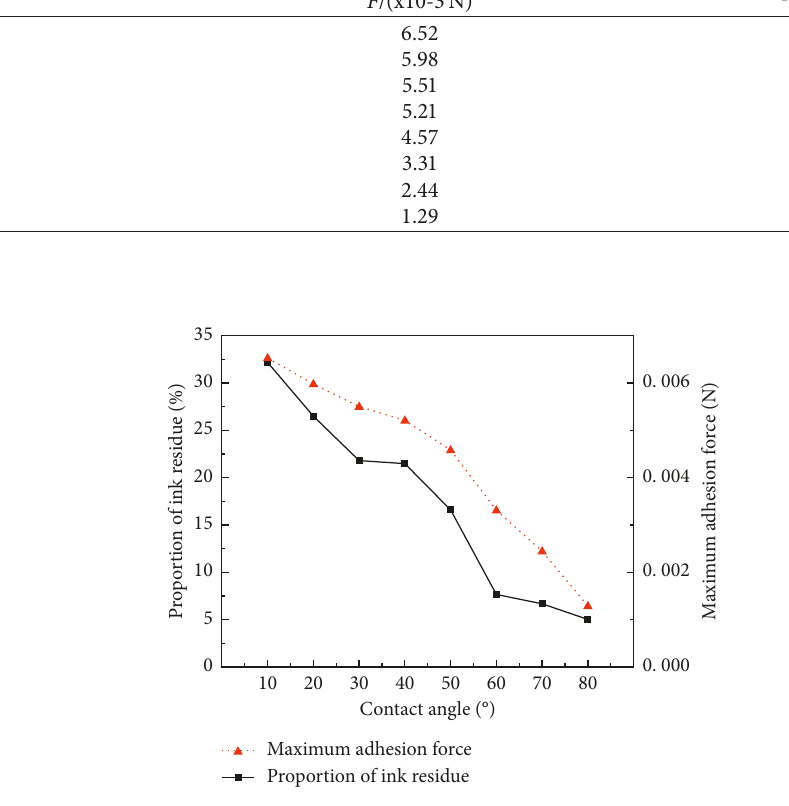
Figure 12: Change trend of ink residue proportion and adhesion under different contact